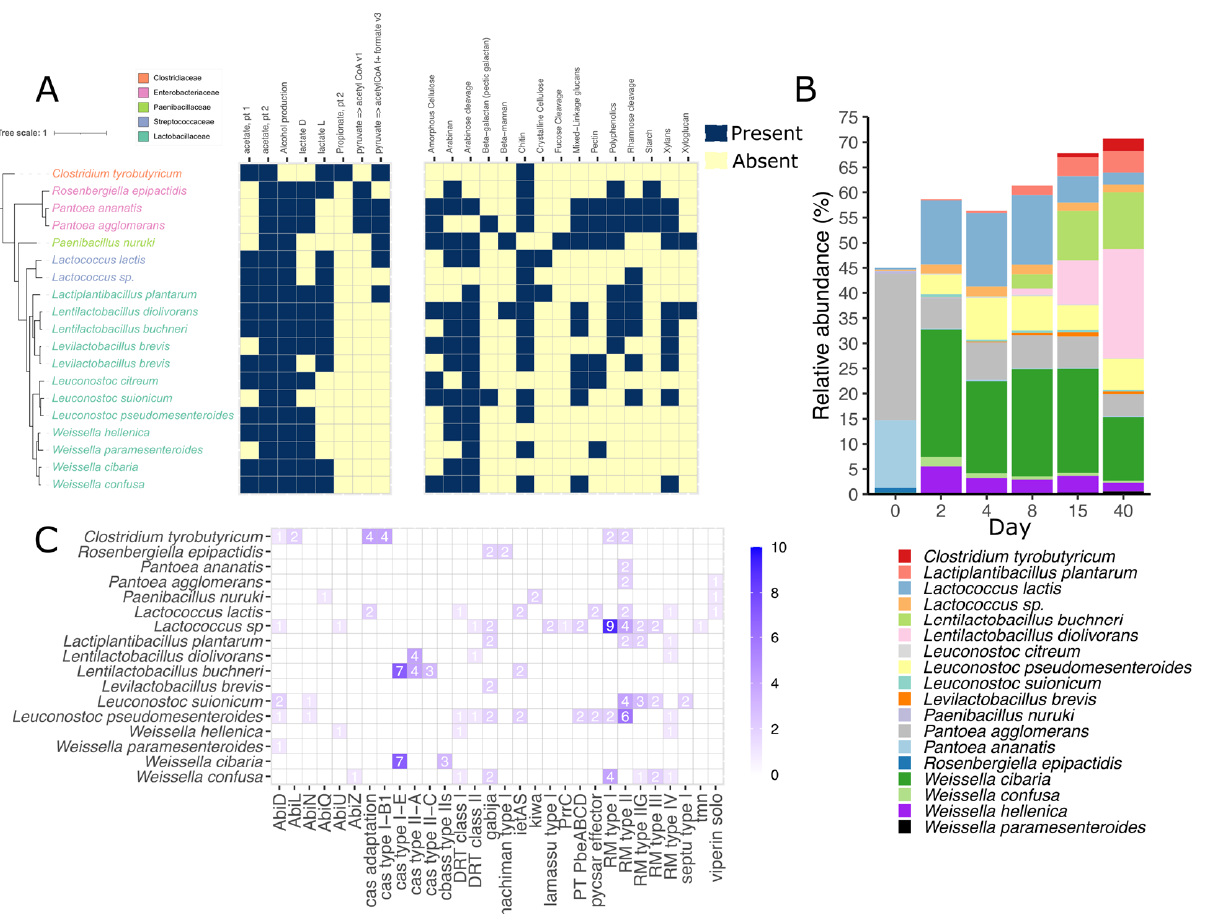
Figure 3. Functional potential of the most abundant bacterial members (MAGs) during grass ensilaging. The tree was constructed based on 400 universal marker genes and rooted at the C. tyrobutyricum node. ( A ) Metabolism is grouped by SCFA and alcohol conversion and carbohydrate-active enzyme targets. ( B ) Relative abundance of the 19 recovered MAGs and ( C ) antiviral defense mechanism found in them. The numbers indicate the number of genes.